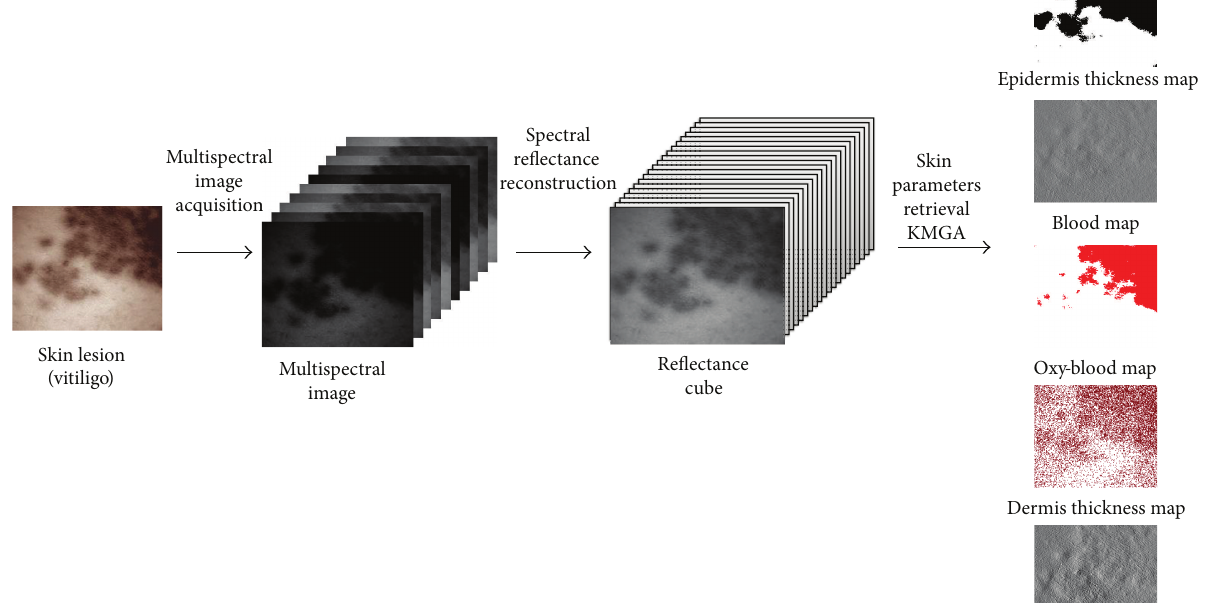
Figure 1: Asclepios full system: from acquisition to skin parameter map retrieval. The system is defined in three steps: (1) the acquisition of a multispectral image, (2) the reconstruction of a reflectance cube containing only skin reflectance information and finally, and (3) the retrieval of skin parameters from the analyzed reflectance cube.